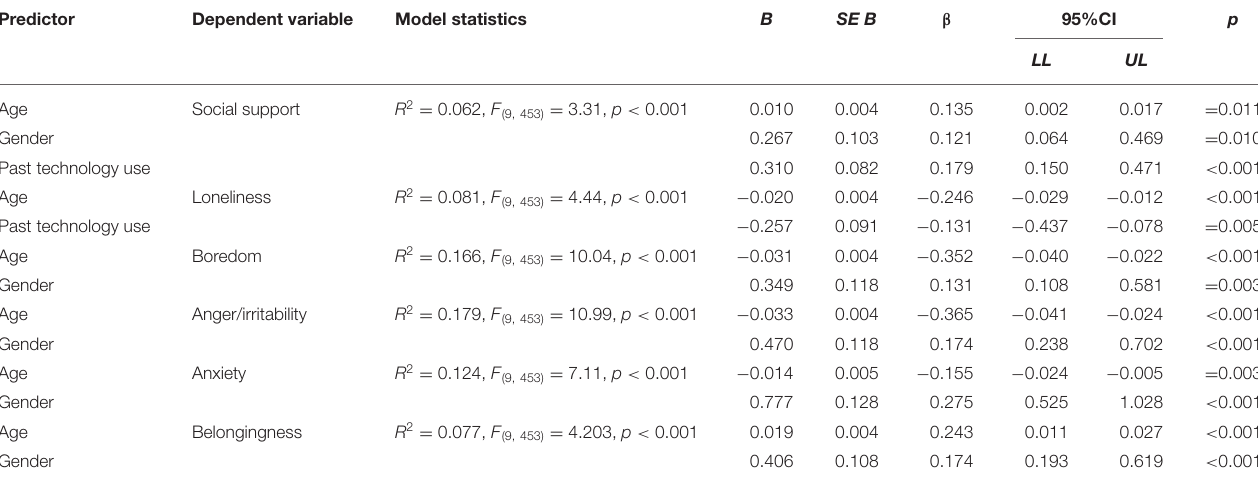
TABLE 3 | Significant results of simple and multiple linear regressions.